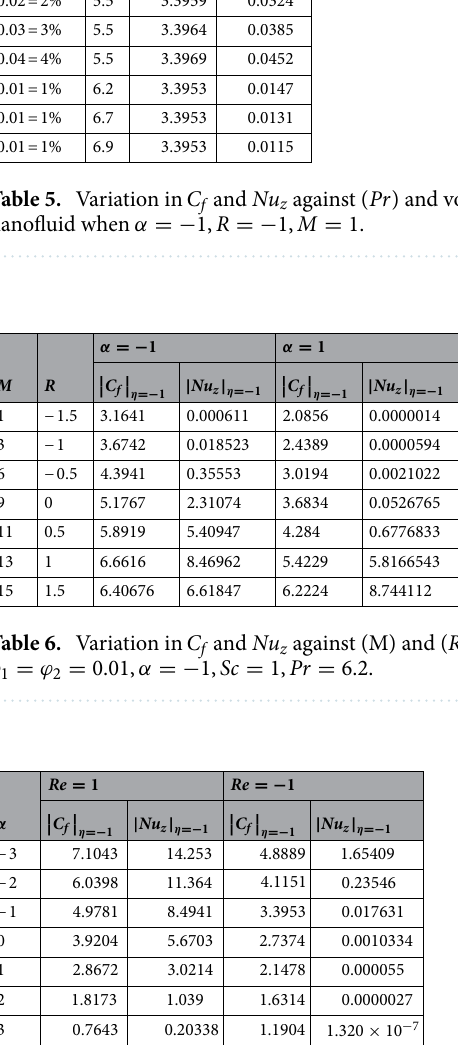
is controlled by the Lorentz force is due to the magnetic effect. Figure 10 represents variation in velocity against (M) through contour lines. It is depicted that contour lines are roughly flat in the area of the midpoint of η and negligible reducing pattern along the problem’s boundary. Figure 11 displays the contour of the influence of vari- able M on the radial velocity. In Fig. 11 contour lines representing variation in radial component of velocity is sketched which shows optimized change in velocity against η at boundaries whereas at center these lines shows zero change. Figure 12 indicates that the contours lines are very similar to the problem’s boundaries as opposed to the center of an area and contributes to the radial velocity maximum being placed in the center of an area. The contour of radial velocity with the variance of parameter R was seen in Fig. 12. It is also noticed that contour lines expand against the boundaries of the main problem and expand in the major component of the field with an appreciation in the value of R which contributes to a reduction in the radial velocity with a fall in the amount of R .